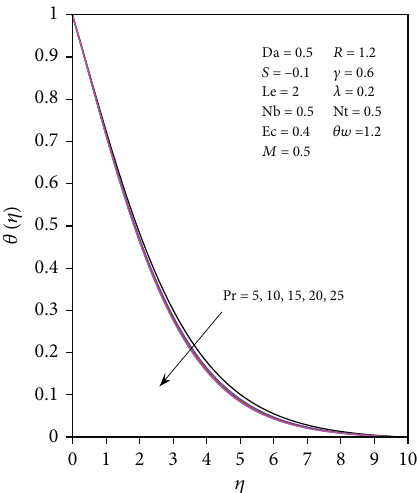
Figure 9: Temperature pro fi le for di ff erent values of Ec .